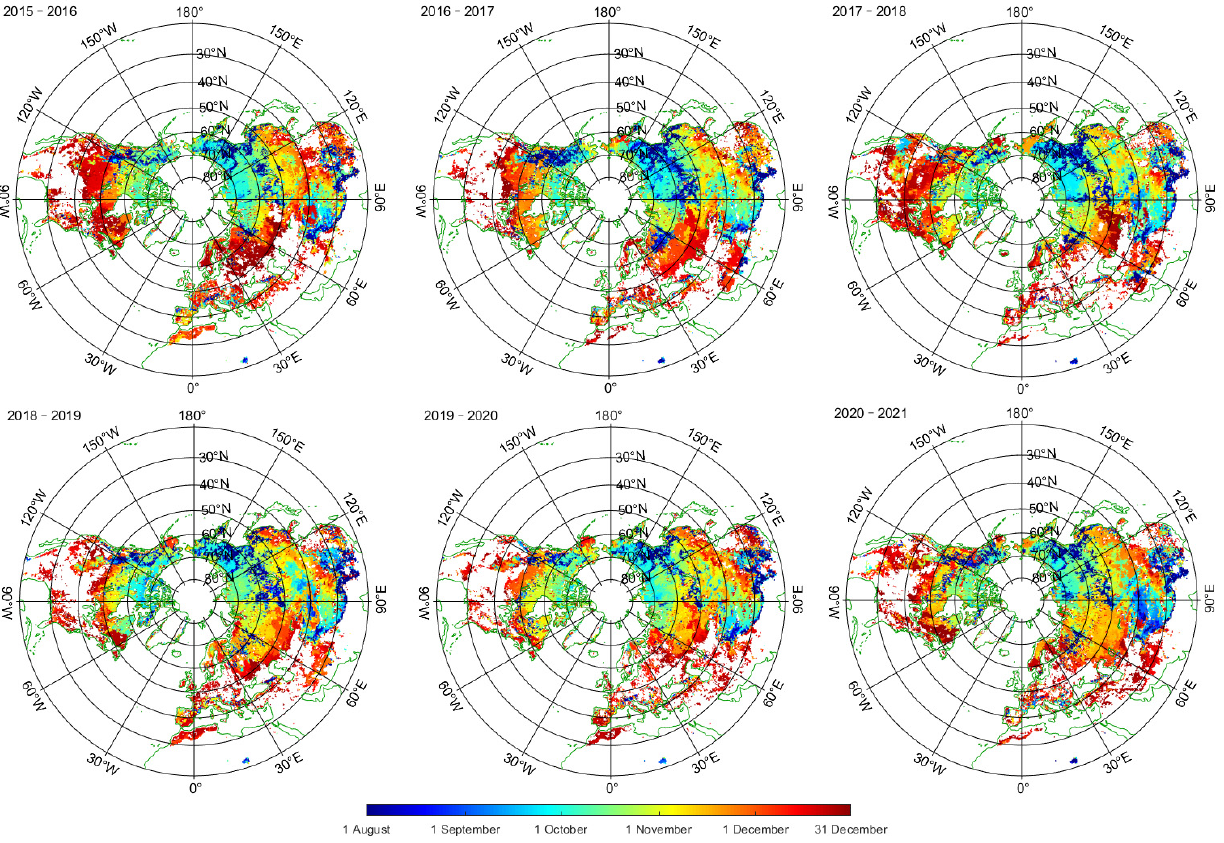
Figure 5. The beginning of the frozen-soil periods of the six winters as inferred by the new FT algorithm over the northern hemisphere (latitude > 20°N).